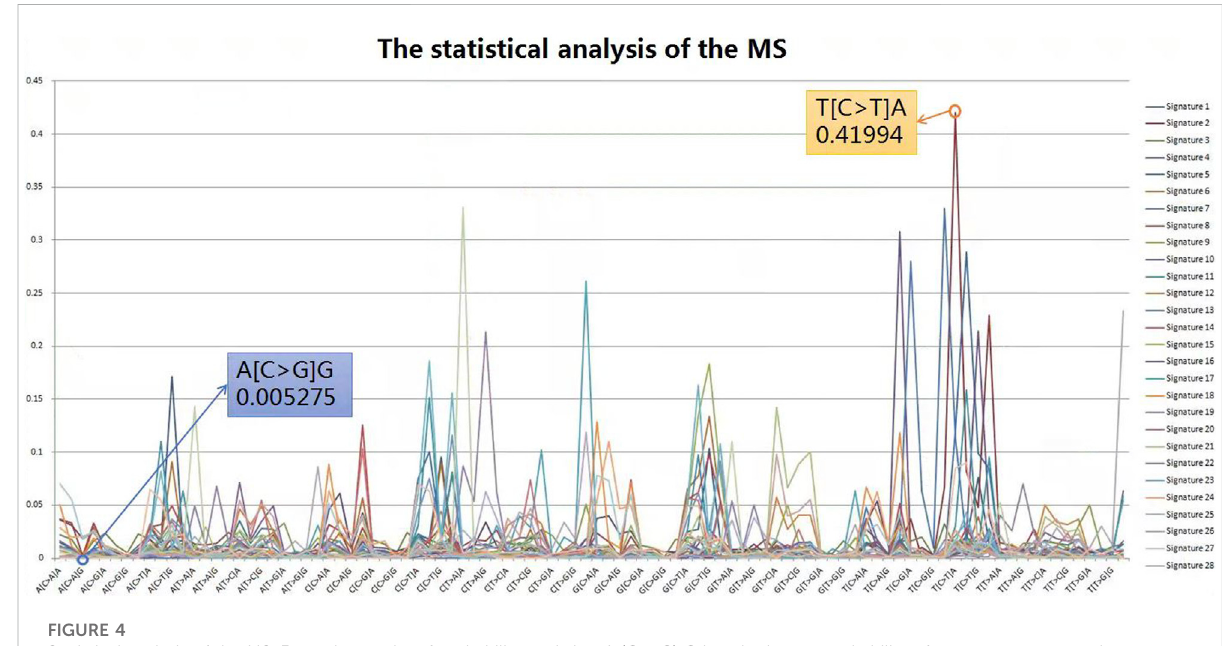
FIGURE 4 Statistical analysis of the MS. From the results of probability statistics, A (C > G) G has the lowest probability of occurrence among the 96 classi fi cations at 0.005275 while T (C > T) A has the highest at 0.41994, a difference of 79.6